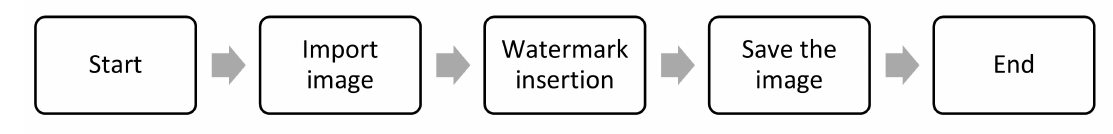
Figure 5. Flow process of watermark insertion in the proposed application.